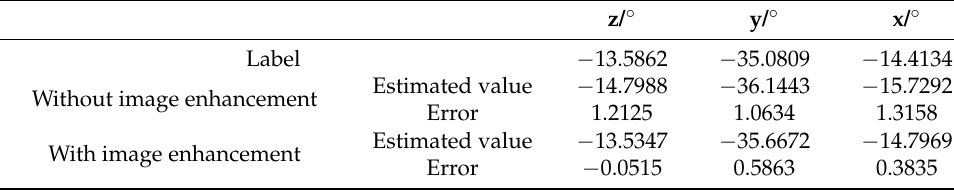
Table 6. The attitude estimation results of test data 2.